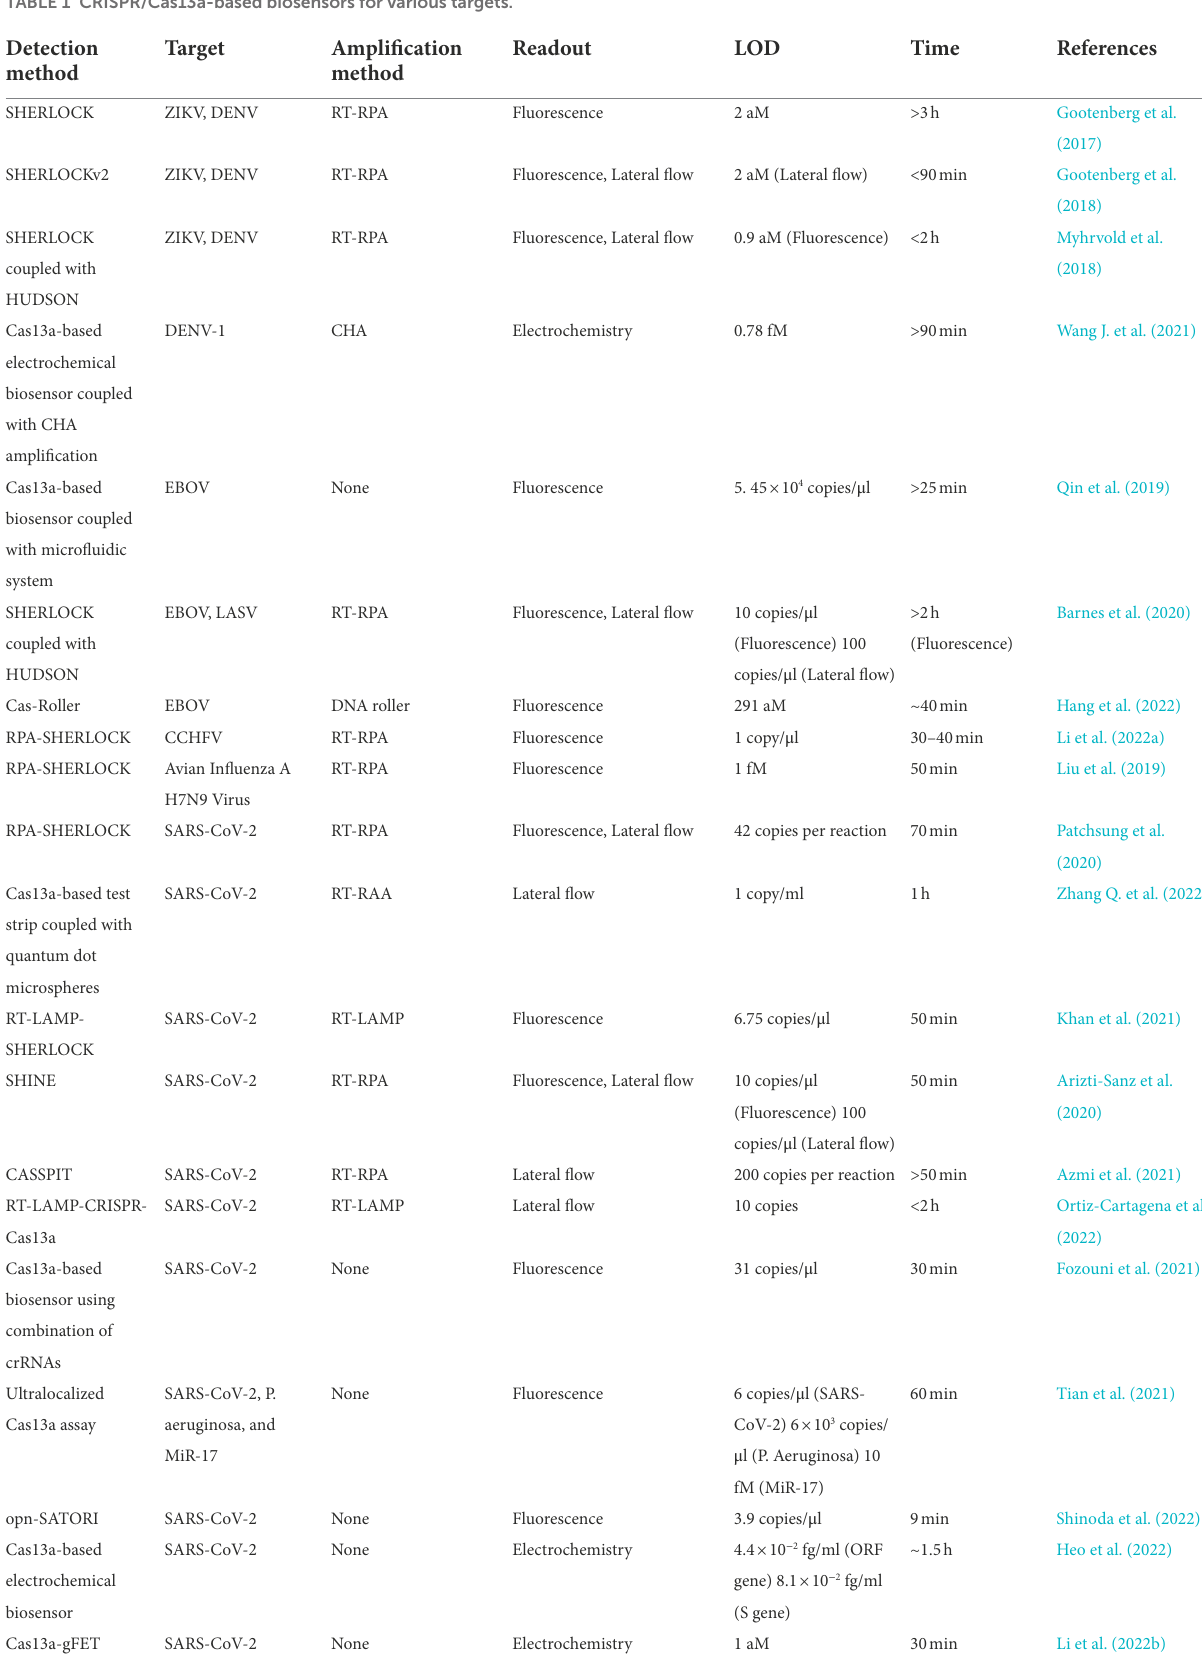
TABLE 1 CRISPR/Cas13a-based biosensors for various